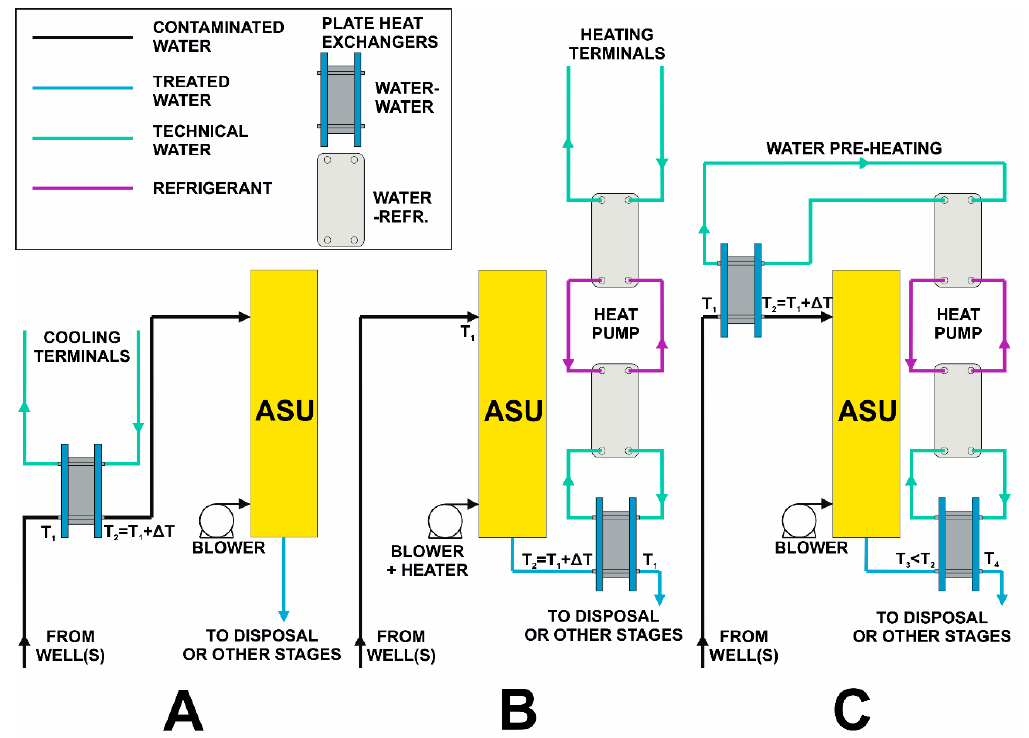
Figure 3. Possible positions for heat exchange in an air stripping system with an air stripping unit (ASU): ( A ) heat discharge from a (free) cooling system on groundwater before treatment; ( B ) downstream heat recovery downstream of the treatment; ( C ) heat recovery downstream of the treatment with a heat pump used to preheat water before treatment.